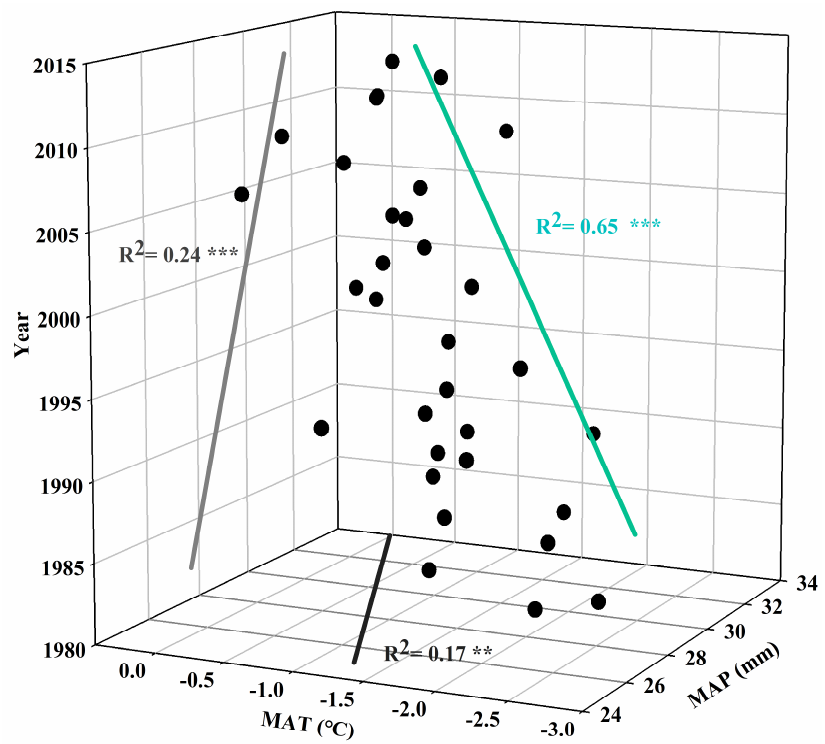
Figure 5. Relationships of MAP, MAT, and years during 1982 − 2013. The gray, green, and black solid lines represent the fitting lines of MAP and Year, MAT and Year, and MAP and MAT, respectively. *** represents the significance at the 0.001 level; ** represents the significance at the 0.01 level.